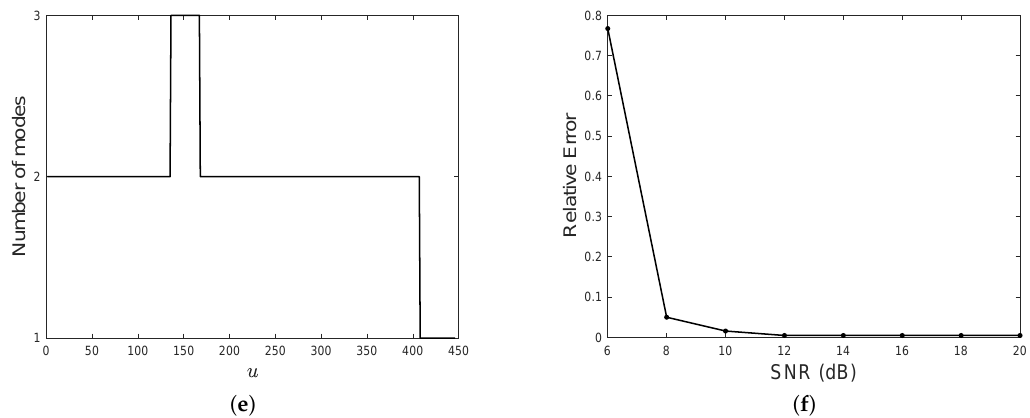
Figure 18. ( a ) AM–FM signal composed of three components embedded with AWG noise, SNR = 10 dB. ( b ) Spectrogram of ( a ), s = 58. ( c ) Optimal threshold provided by MDL functional minimization, according to Equation (18). ( d ) Binary map derived from ( b ). ( e ) Estimated number of modes. ( f ) Relative counting error against SNR.